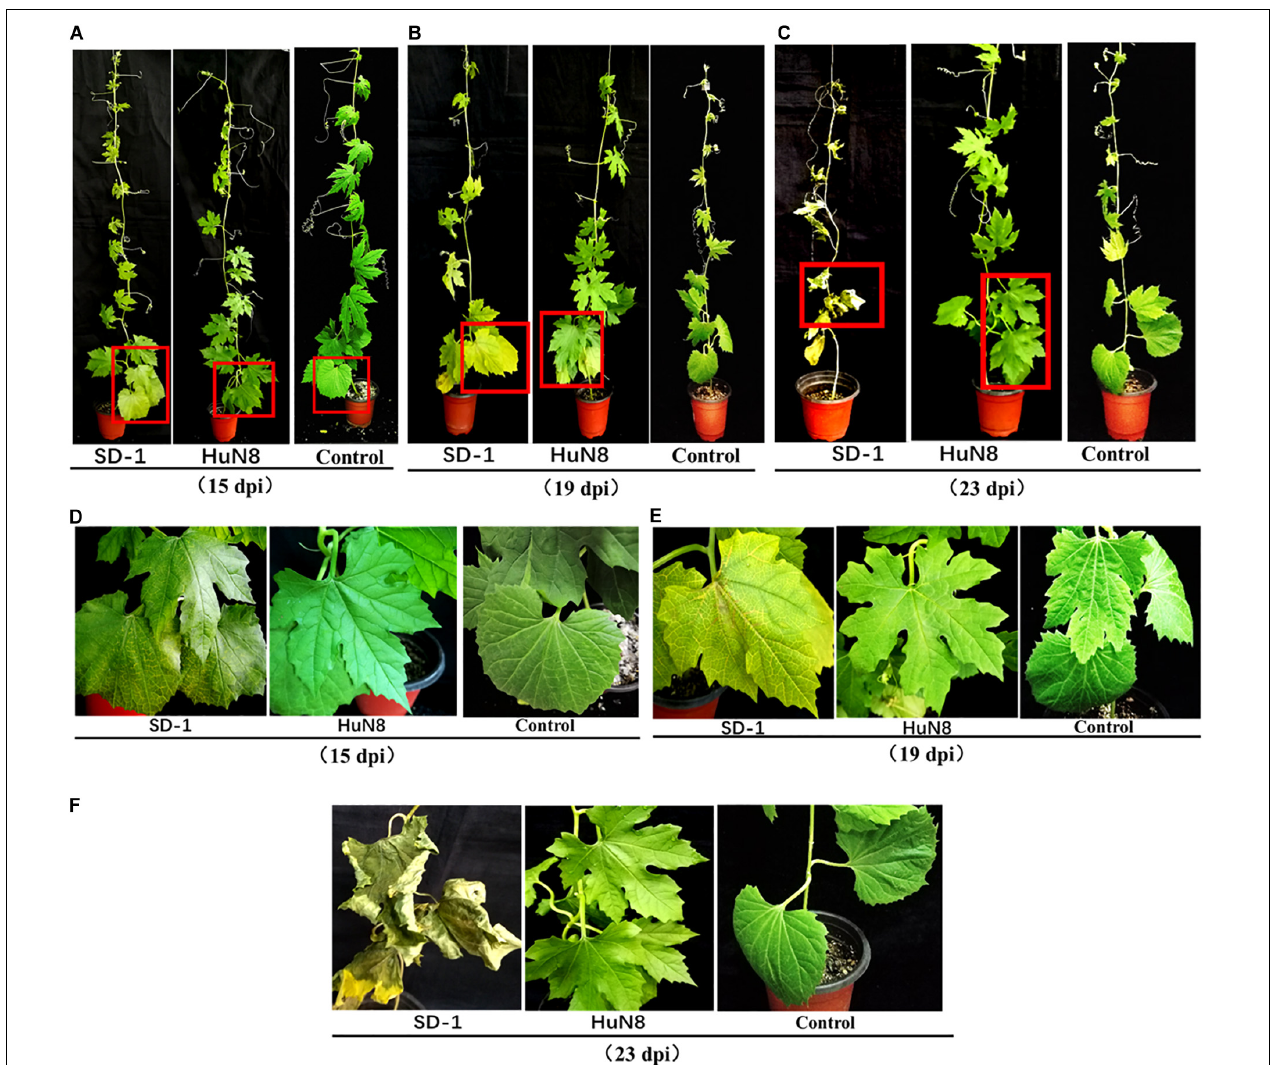
FIGURE 5 | Pathogenicity detection of strains HuN8 and SD-1 in living bitter gourd seedlings. (A–C) Symptoms at the early (15 dpi), middle (19 dpi), and later (23 dpi) stages. (D–F) The enlarged images of the red boxes in (A – C) , respectively.